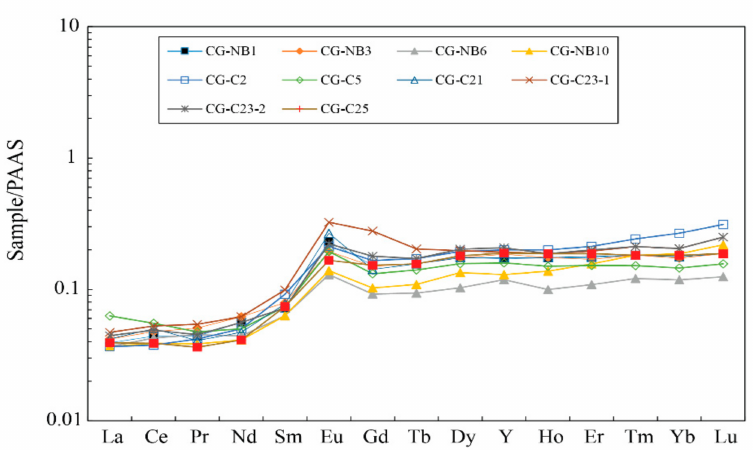
Figure 9. PASS-normalized REE patterns of the Nabeba BIF. Normalizing values from McLennan [49]. Determining Ce anomalies is often complicated due to the anomalous behavior of La. Bau and Dulski [3] suggested the use of Ce/Ce* vs. Pr/Pr* diagram to determine La and Ce anomalies in BIFs. The Ce/Ce* and the Pr/Pr* ratios were calculated as Ce SN /(0.5 La SN + 0.5 Pr SN ) and as Pr SN /(0.5 Ce SN + 0.5 Nd SN ), respectively. The Ce/Ce* vs. Pr/Pr* plot indicated that the majority of our samples had no negative Ce anomalies and had very small to negligible positive La and Ce anomalies (Figure